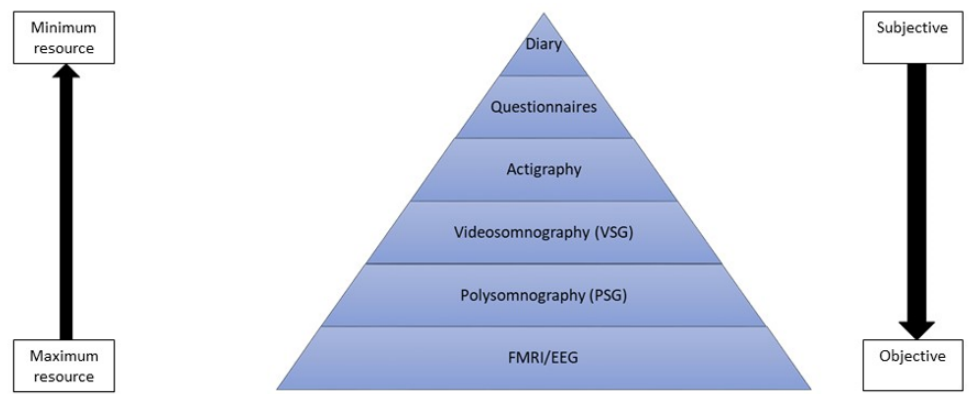
Figure 1. Trade-off between cost/availability and sensitivity of measures of sleep.